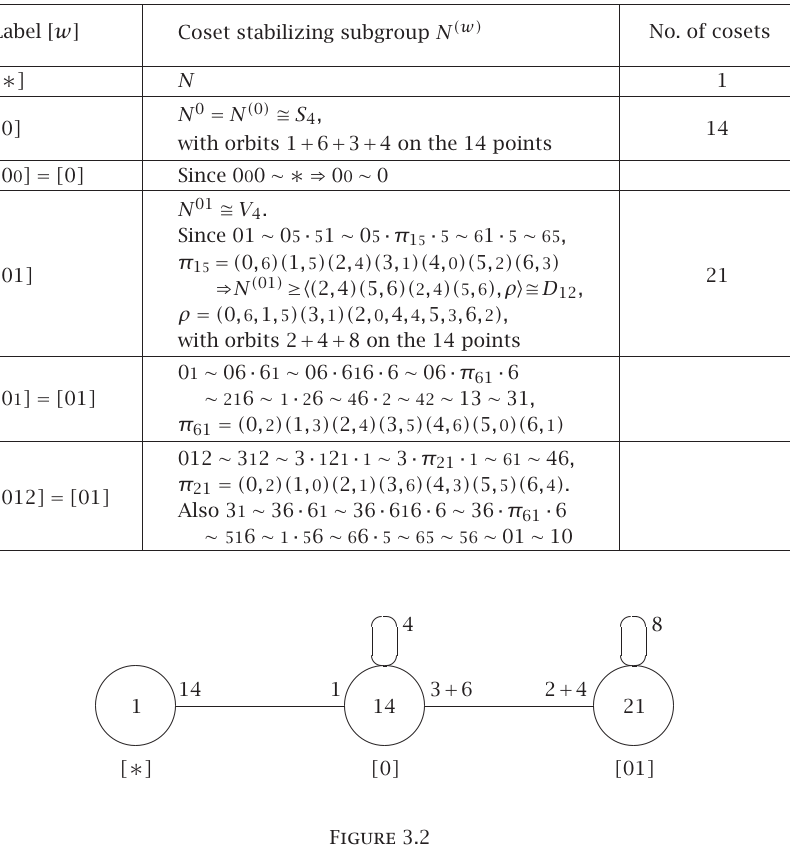
Table 3.1 . Double coset enumeration for U